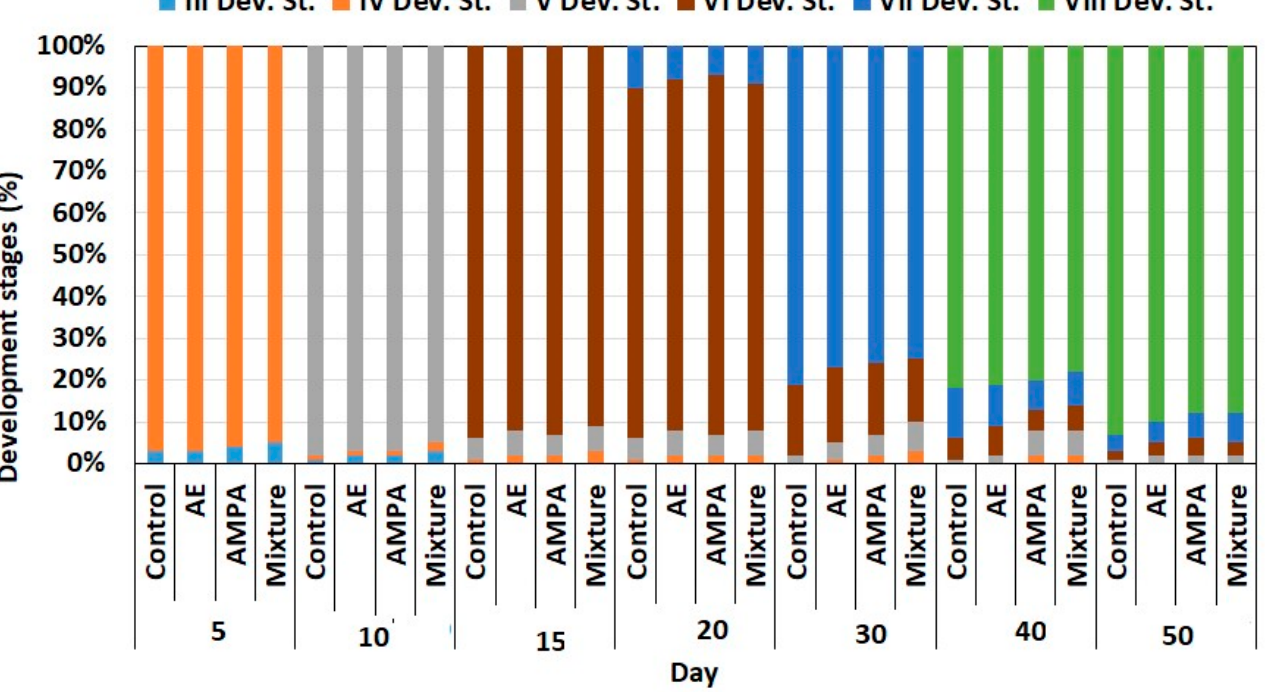
Figure 2. Marbled crayfish Procambarus virginalis developmental stages during 50-day exposure to acetochlor ESA (AE, 4.0 µg/L, N = 31), aminomethylphosphonic acid (AMPA, 4.0 µg/L, N = 32), and their combination (AE, 4.0 µg/L + AMPA, 4.0 µg/L, N = 29), and in control (no exposure, N = 30.